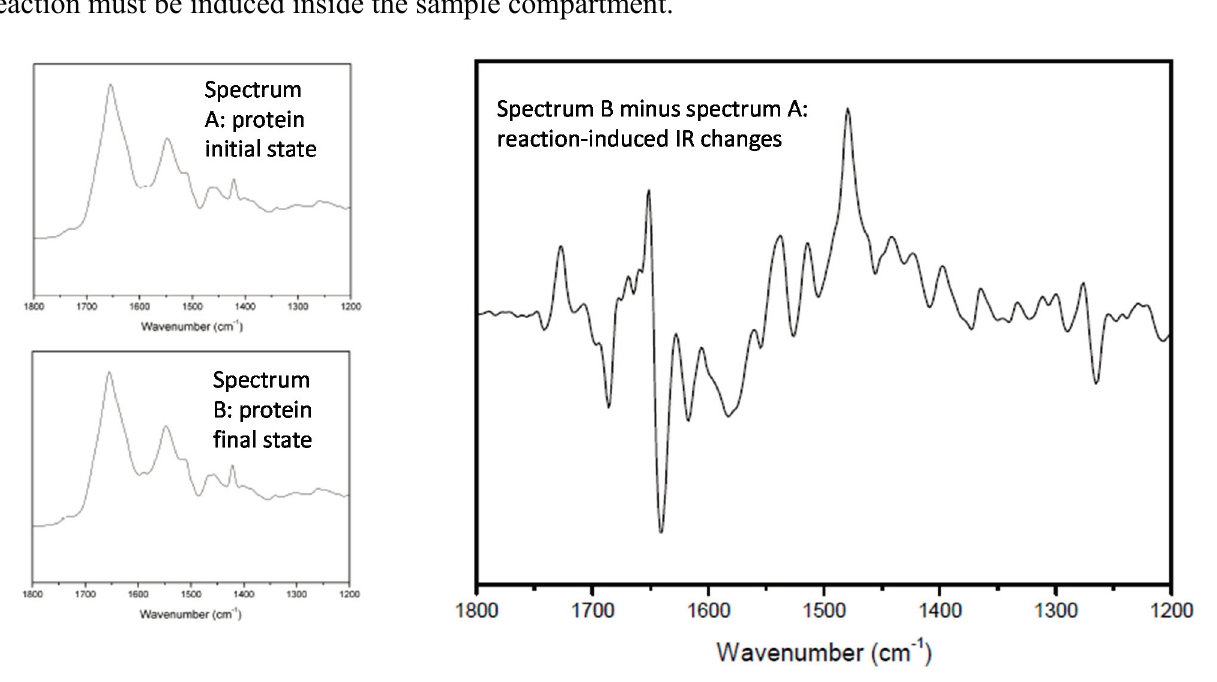
Figure 1. Principle of IR-DS. The figure shows a classical example of photosynthetic reaction, the mono-electronic reduction of the so-called Q B (quinone) in a bacterial